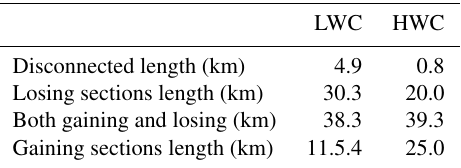
Table 3. Length of disconnected sections, connected gaining sec- tions and connected losing sections, and head difference between the water table and riverbed calculated from preliminary mapping, for LWC and